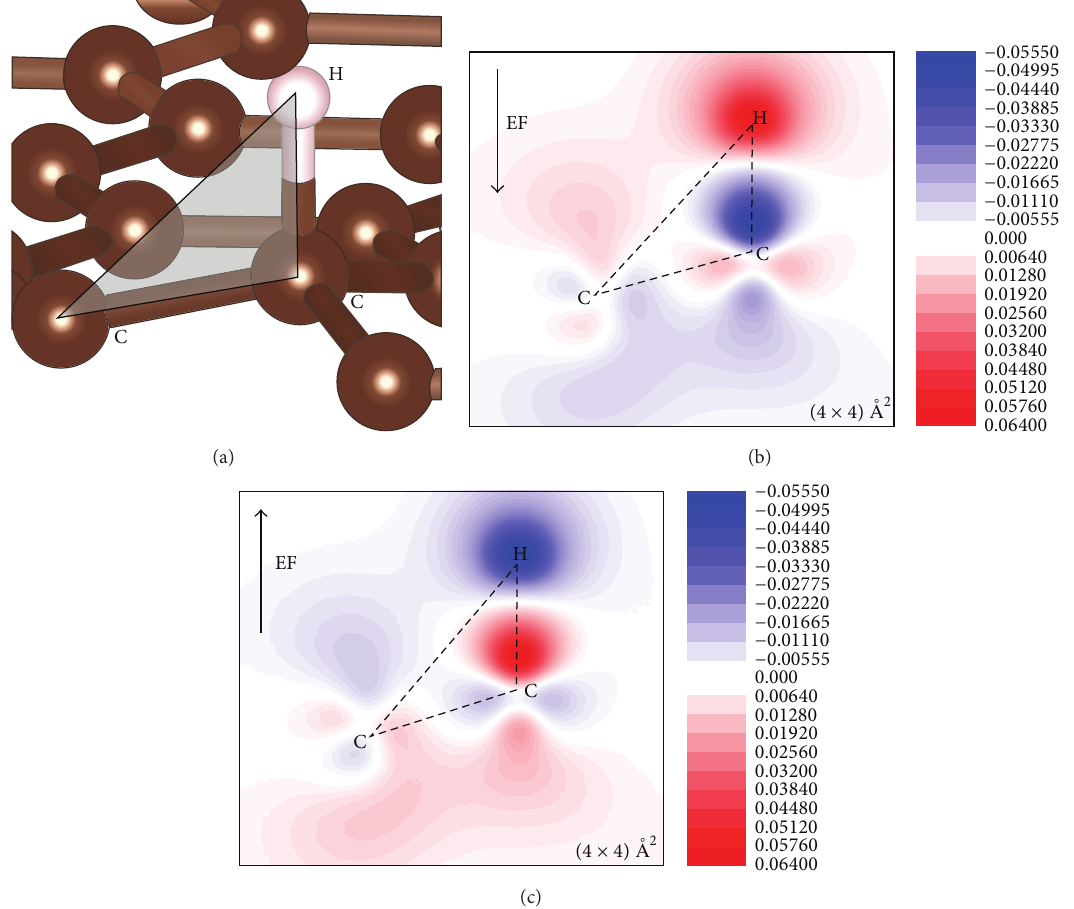
Figure 8: (a) Planar projection of the chemisorption state; (b) charge density (e/˚A 3 ) resulting from the subtraction of H/G charge without EF to the systems with an EF of − 1.25 V/˚A intensity and (c) 0.75 V/˚A. The density changes are represented on a colored scale, with red and blue relating to increases and decreases,